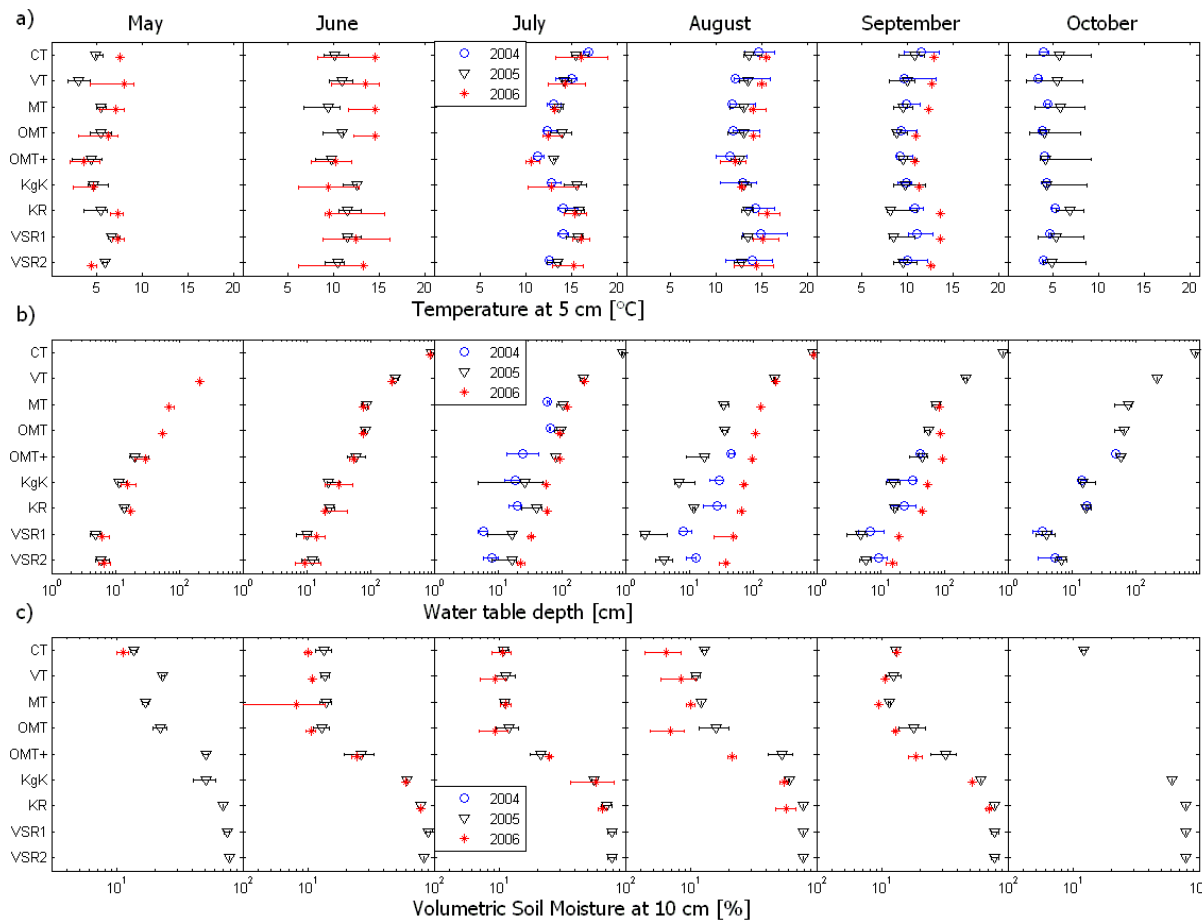
Figure 2. The panels (a–c) show the monthly medians of environmental variables: (a) soil temperature at a depth of 5cm, (b) ground water level, and (c) volumetric soil moisture at 10cm depth observed along the forest–mire ecotone during wet (2004), intermediate (2005), and dry years (2006). The top–down arrangement of sites mimics the locations on the slope (see Fig. 1). The error bars represent the 25th and 75th percentiles. Table 4. Parameter estimates and their standard errors for forest floor N 2 O fluxes (µgm − 2 h − 1 ) of all forest/mire types (CT–VSR2) in one group Eq. (4). Eq. (4) is function of volumetric soil moisture at 5cm (%) and soil temperature at a depth of 5cm ( ◦ C). Eq. (4) a 0 a 0 SE T opt T opt SE